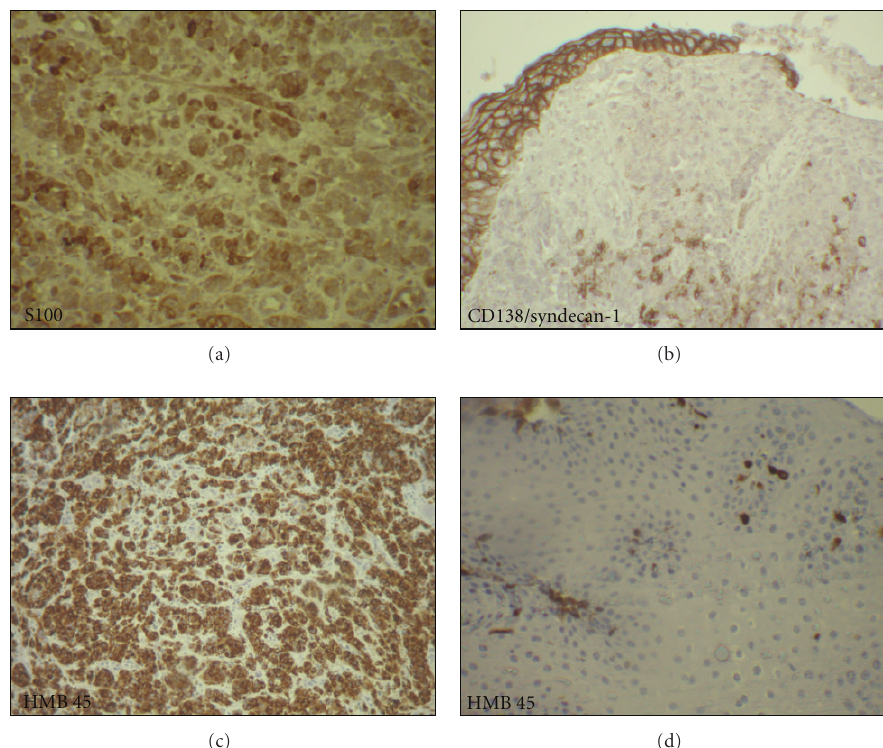
Figure 6: (a) Neoplastic cells showed strong positivity with S100 protein ( × 100). (b) Focal expression for CD138/syndecan-1 ( × 100). (c) Neoplastic cells showed strong positivity with HMB45 ( × 40). (d) HMB45 staining showing increased number of melanocytic cells at the basal layer of the squamous epithelium ( ×